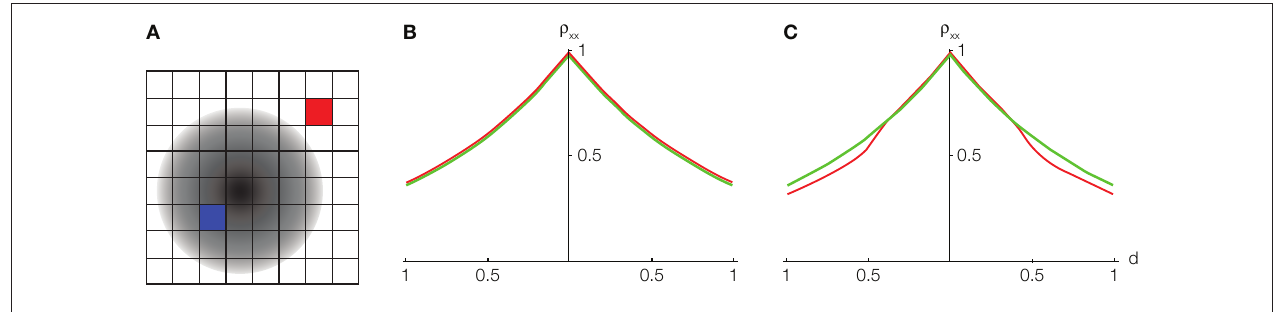
using the model considered in the text with stimulus present (red) and absent (green). We assumed that one pixel is located at the stimulus center ( d stimulus dependent change in correlations is undetectable. (C) Same as in (C) , except that the activity of cells not tuned to the stimulus is decreased by 50% in the presence of stimulus. Compare to Figure 2F in Chen et al.